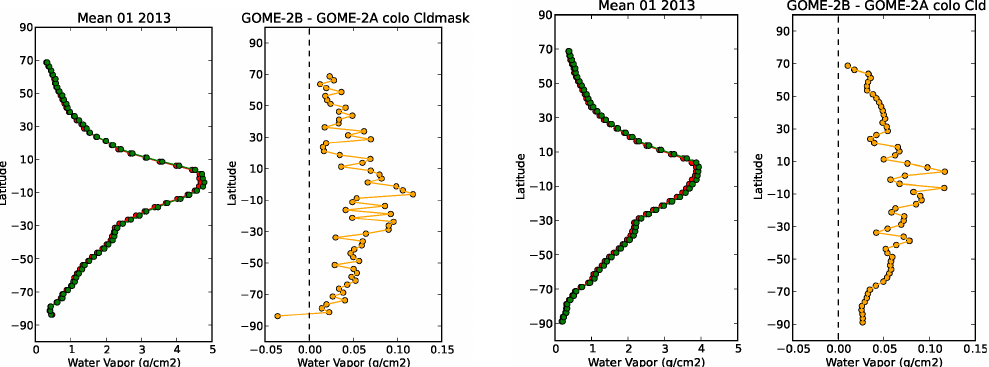
Figure 7. Zonal mean H 2 O total column from GOME-2A (red points) and from GOME-2B (green points) as a function of latitude for January 2013 and bias between GOME-2B and GOME-2A monthly averaged H 2 O total column. The results refer to daily co-located GOME-2A and GOME-2B measurements with cloud mask (left plot) and without cloud mask (right